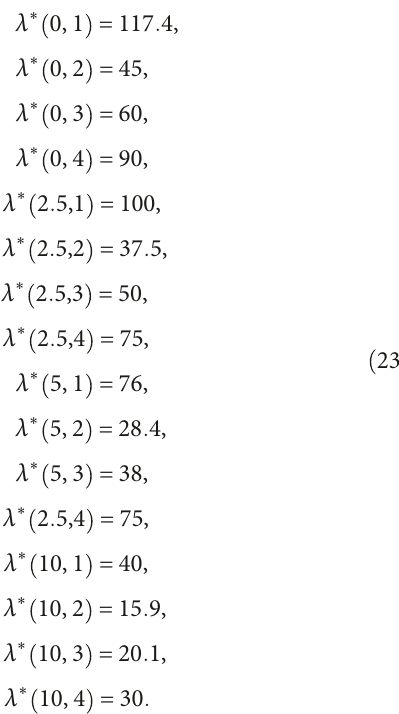
Table 3: Some data of AVaR η ∗